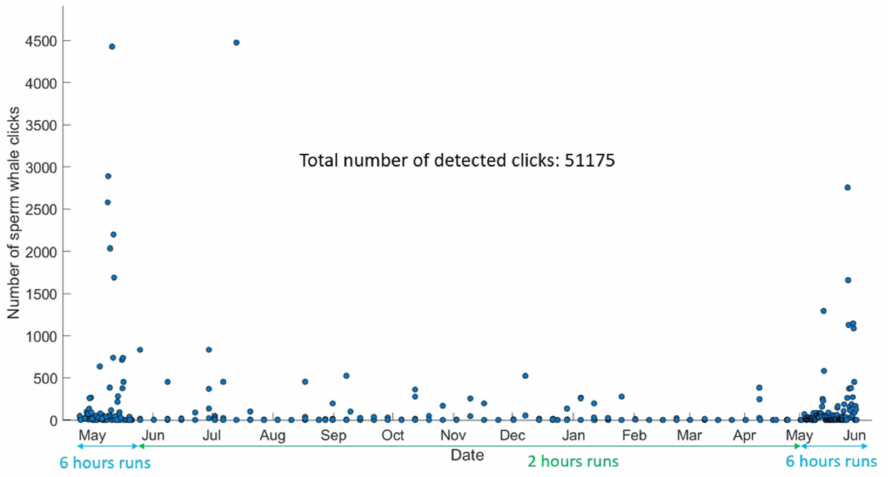
Figure 1. Number of sperm whale clicks as a function of time recorded between the beginning